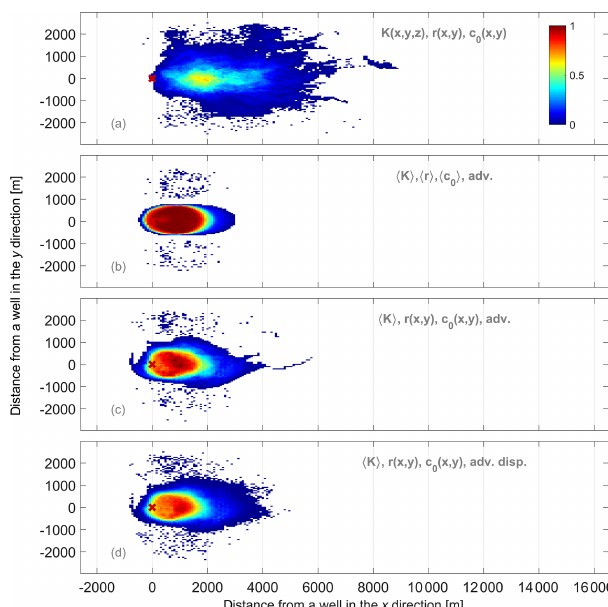
Figure 8. Probability of a particle leaving a given grid cell to reach a well accounting for a heterogeneous K field, heterogeneous r and heterogeneous c 0 (reference case, a ); an upscaled K value, aver- aged r and averaged c 0 accounting for advection only (b) ; an up- scaled K value, heterogeneous r and heterogeneous c 0 accounting for advection only (c) ; an upscaled K value, heterogeneous r and heterogeneous c 0 accounting for advection and dispersion (d)